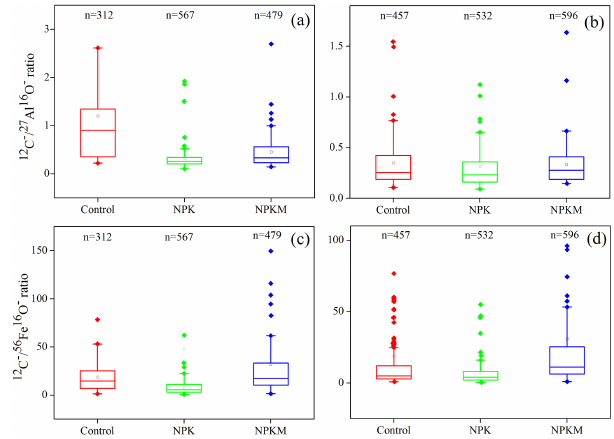
Figure 3. Box plots of 12 C − / 27 Al 16 O − (a, b) and 12 C − / 56 Fe 16 O − (c, d) ratios reflecting the 12 C − rich ROIs (a, c) and 12 C − less rich ROIs (b, d) of the soil colloids from three contrasting long-term (1990–2014) fertilization treatments using NanoSIMS (for all spots). Control, no fertilization; NPK, chemical nitrogen, phosphorus, and potassium fertilization; NPKM, chem- ical NPK plus swine manure fertilization. The 12 C − rich ROIs include the areas above 90 pixels, and the 12 C − less rich ROIs include the areas in the range of 90–40 pixels under control and NPK, which were above 50 pixels and in the range of 50–30 pixels under NPKM. The number n in figures represents the number of the selected ROIs. The line in the middle of the box is the median value and the square in the box is the mean value. The lines that protrude out of the boxes represent the 25th and 75th population percentiles. Outliers are shown as diamonds.